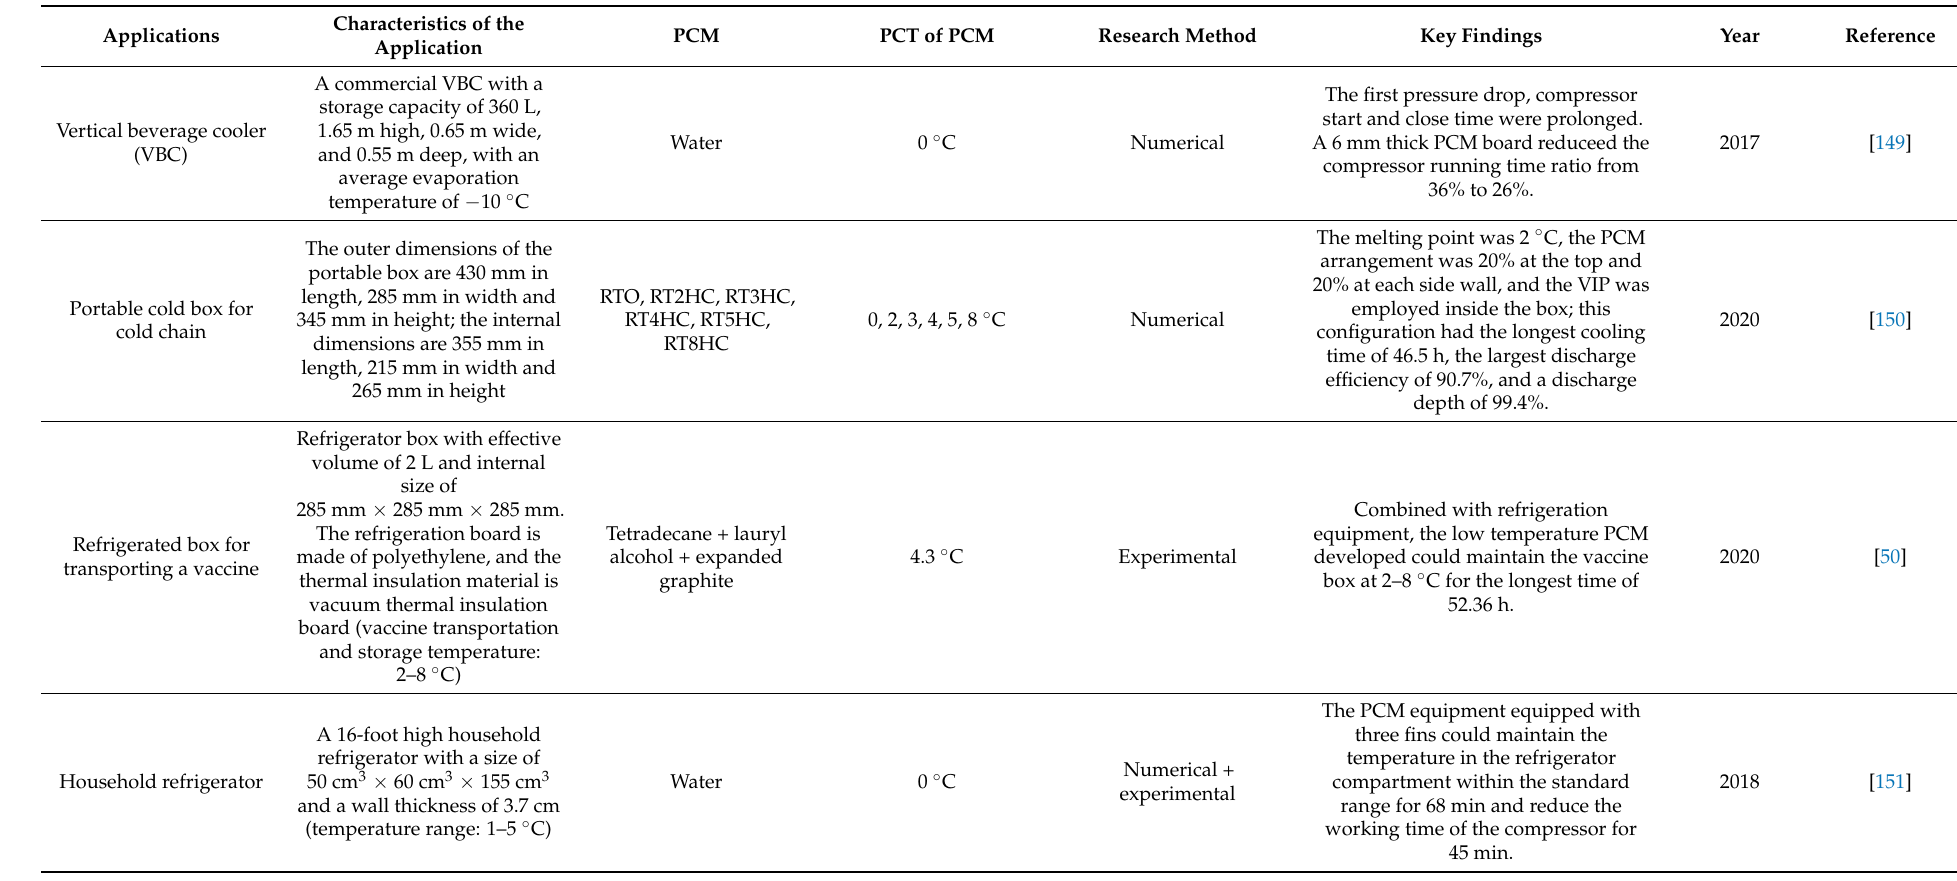
Table 11. Typical applications of cold storage PCMs in